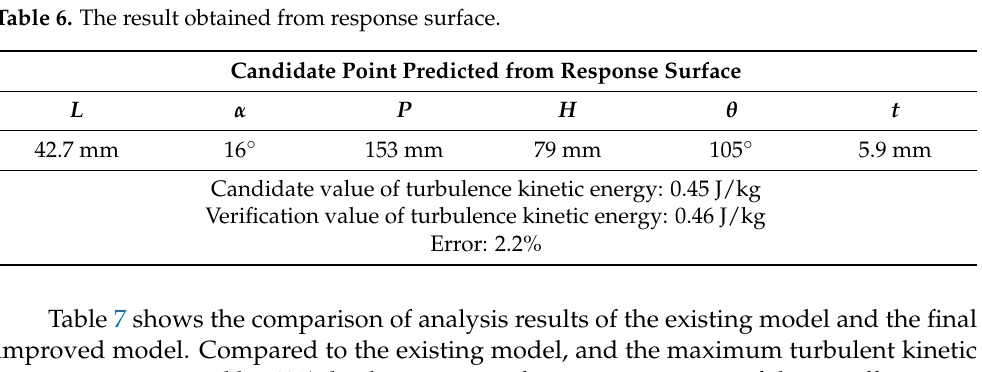
Table 6. The result obtained from response surface.